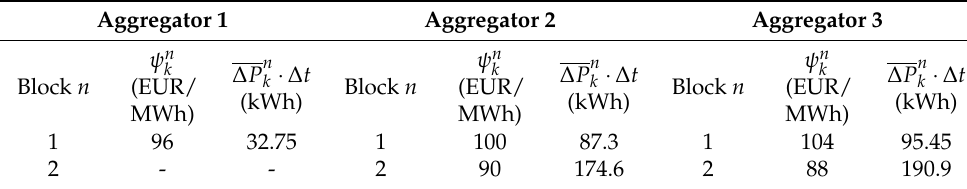
Table 4. Downward balancing energy bids submitted by aggregators.